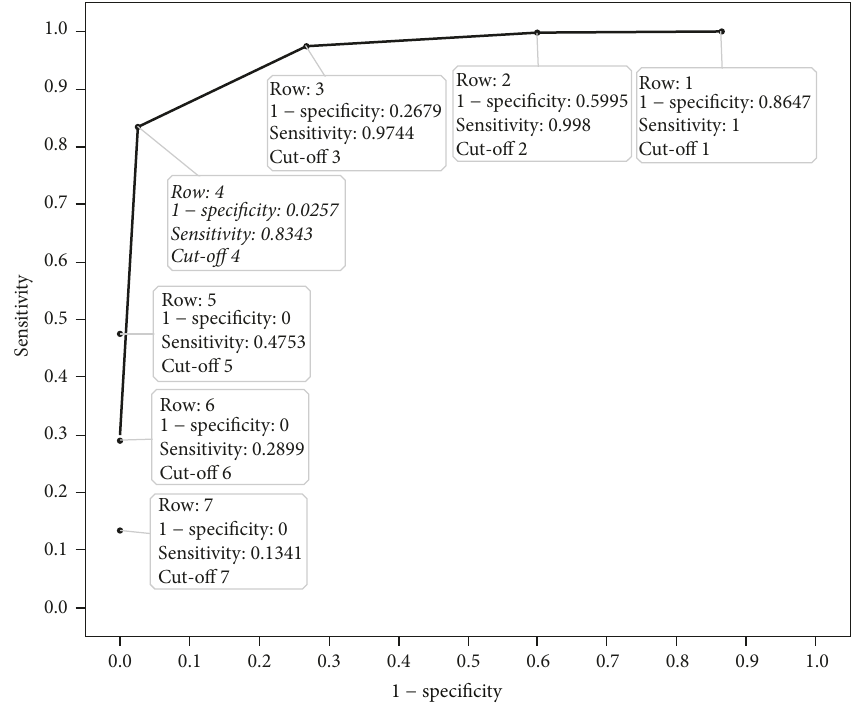
Figure 3: Receiver Operating Characteristic (ROC) curve. The ROC curve is generated from seven different cut-off points of global scores on “shortPSQI” survey, using sensitivity (true positive) and 1 − specificity (specificity = true negative; 1 − specificity = false negative) with respect to cut-off 5 on original PSQI questionnaire. The cut-off of > 4 on the global score of the “shortPSQI” demonstrates the highest sensitivity and specificity compared to the other cut-off values.